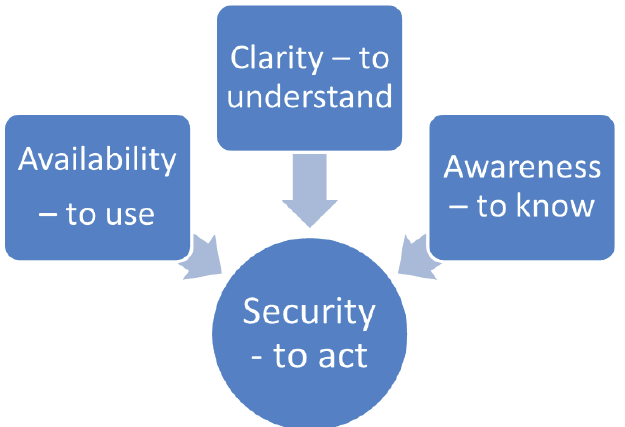
Figure 1. Show the results four